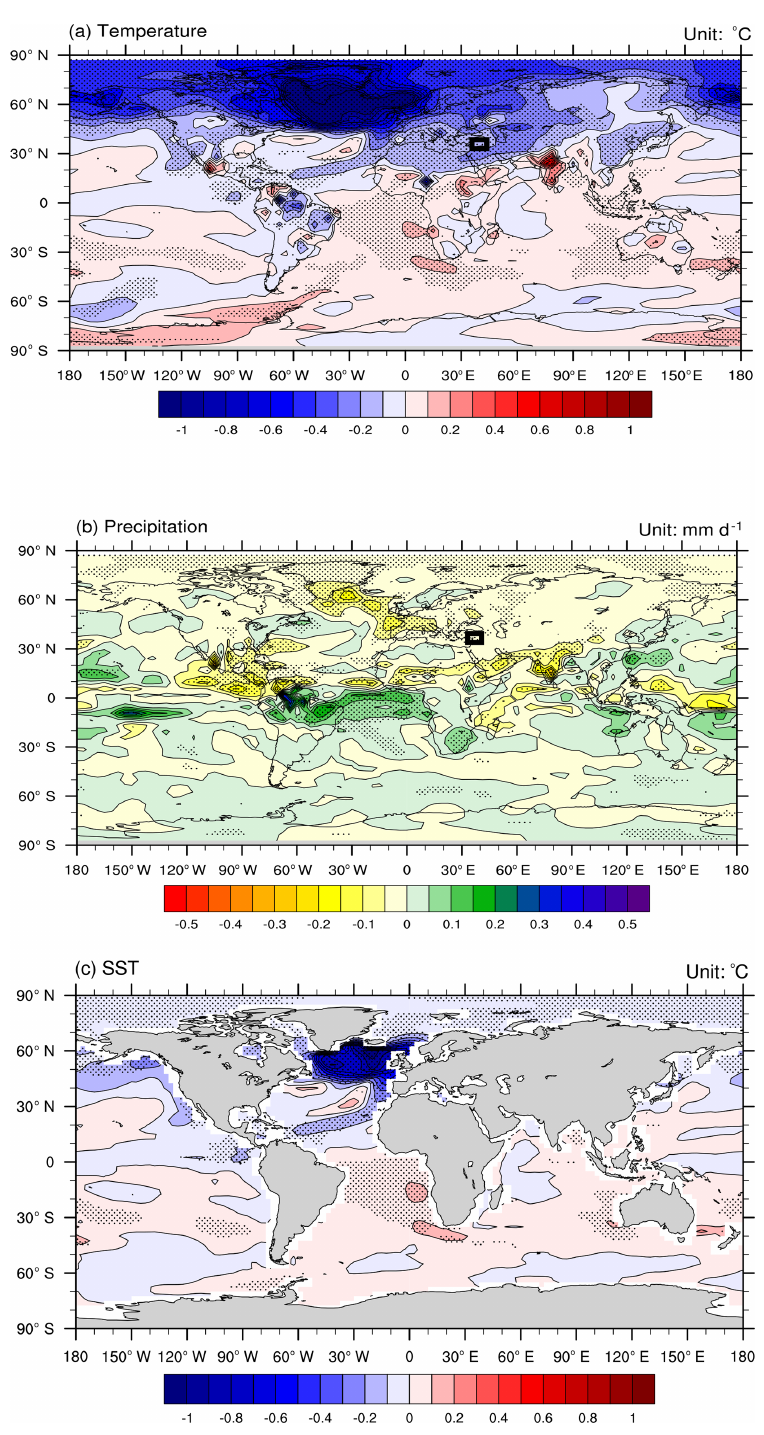
Figure 2. The changes of (a) surface temperature ( ◦ C), (b) precipitation (mmday − 1 ), and (c) SST ( ◦ C) after 4.5ka (between 4500–4000 and 4800–4500BP). The rectangles in panels (a) and (b) indicate the region with major dry-farming settlement abandonment around 4.2ka, according to Weiss